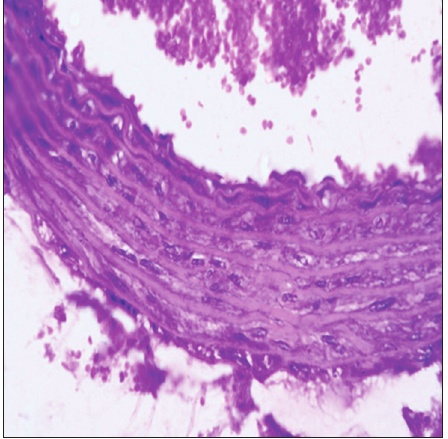
Figure-8: Group I aorta note normal endothelium with free erythrocytes in the lumen of aorta (H and E,